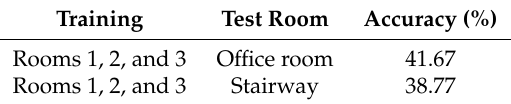
Table 9. Accuracy of the model trained on our recorded dataset and tested on the public dataset.